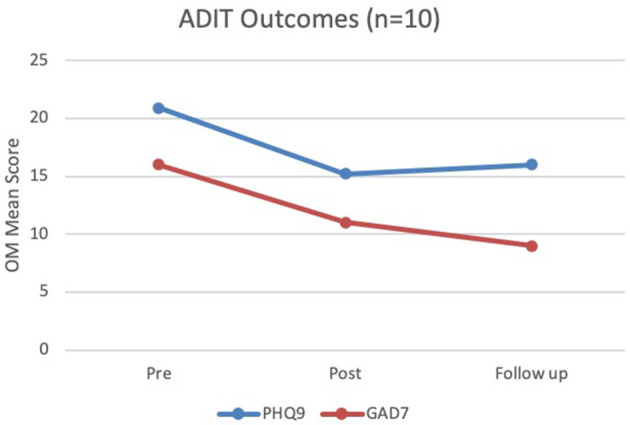
Pilot outcomes (n = 10).